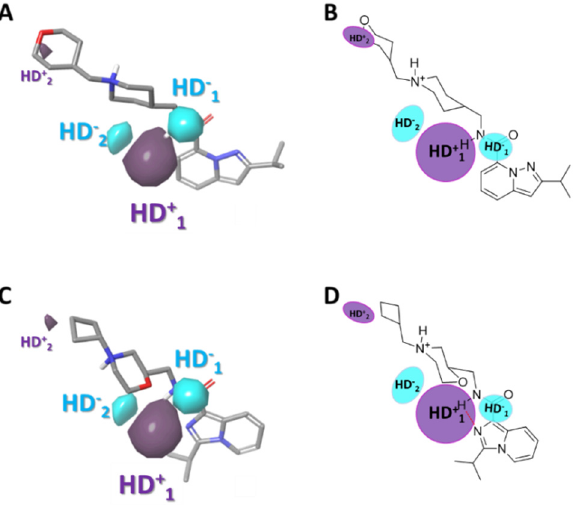
Figure 7. Contour maps obtained for the best Gaussian-based 3D-QSAR model hydrogen bond donors (HD), violet regions indicate favorable hydrogen bond donor interactions and cyan regions indicate unfavorable hydrogen bond donor interactions. The active molecule ( 53 ) is represented in ( A ) (sticks representation) and ( B ) (as draw representation). The less active molecule ( 5 ) is represented in ( C ) (sticks representation) and ( D ) (as draw representation).